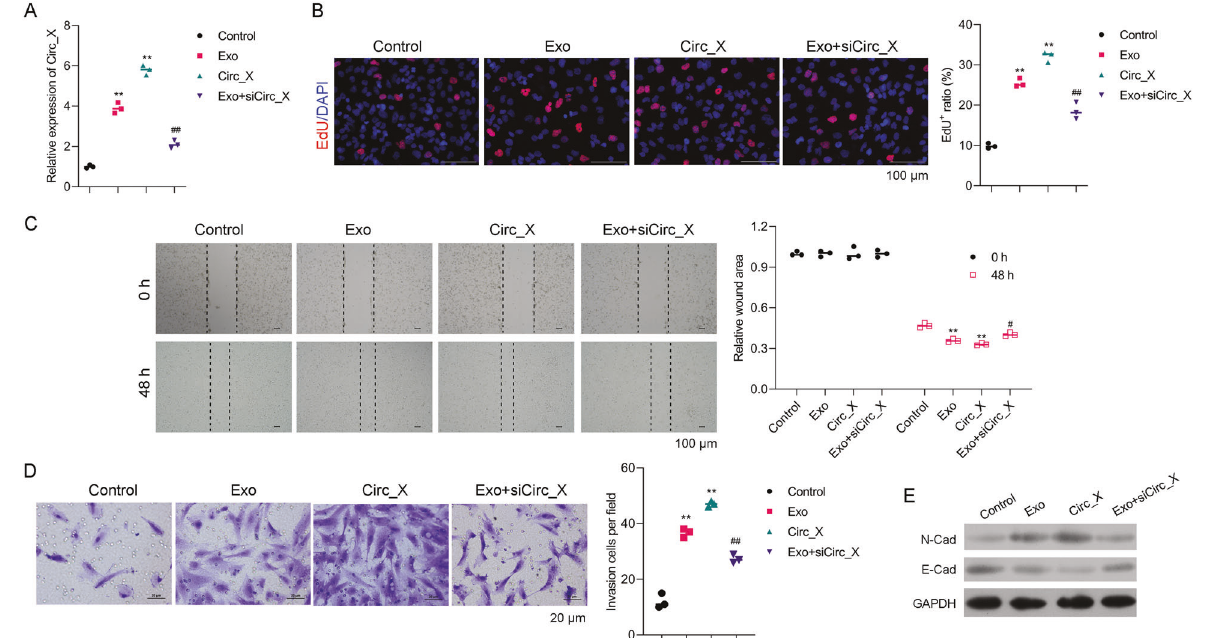
Fig. 4 Hsa_Circ_0020256 was highly expressed in TAM-secreted exosomes and regulated the exosome-enhanced proliferation, migration, and invasion of CCA cells. A RBE cells were co-cultured with exosomes (Exo), transfected with hsa_Circ_0020256 (Circ_X) or both treated with exosomes and transfected with hsa_Circ_0020256 siRNA (Exo + siCirc_X). B Hsa_Circ_0020256 expression was detected by real- time PCR. The respective images of Edu staining assays and a summary of results from three different experiments are shown. C Cell monolayers were wounded and images were acquired at 0 and 48 h. D The respective images of Transwell assays are shown (lower panel). The results of cell invasion assays as summarized from three independent experiments. E Cells were treated as described above and lysed for western blot assays. ** p < 0.01 compared with the Control group. # p < 0.01 and ## p < 0.01 compared with the Exo